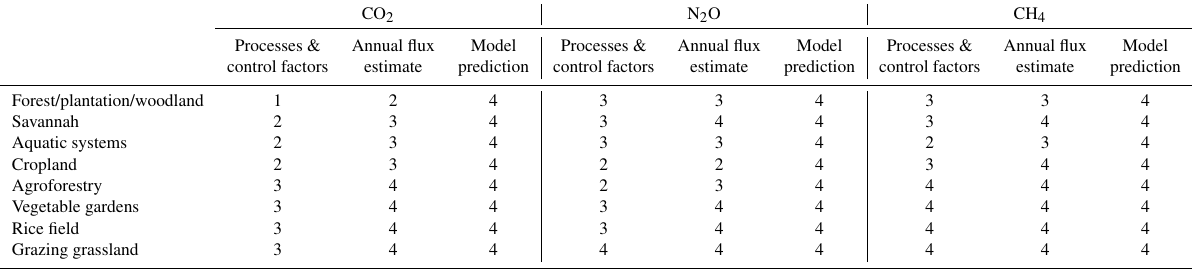
Table 5. Summary of status of knowledge of greenhouse gas emission processes, control factors, estimation, and model prediction. CO 2 Processes & Annual flux Model Processes & Annual flux Model Processes & Annual flux Model control factors estimate prediction control factors estimate prediction control factors estimate prediction Forest/plantation/woodland